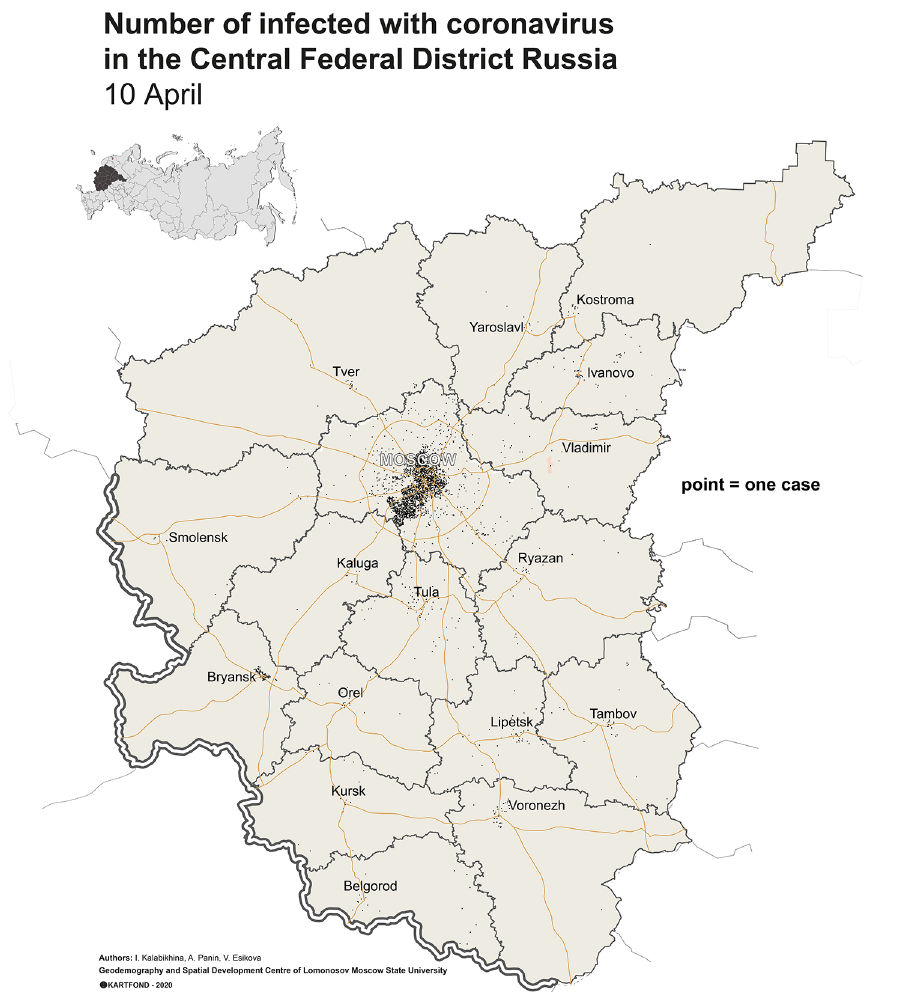
Figure 17. Geographical distribution of COVID­19 cases in the municipalities of the Central Federal District of Russia, number of reported COVID­19 cases, 10.04.2020, according to Rospotrebnadzor (2020). Source: Compiled by the researchers of the Geodemography and Spatial Development Centre of the Population Department of the Economics Faculty of Lomonosov Moscow State University to­ gether with the “Kartfond” research